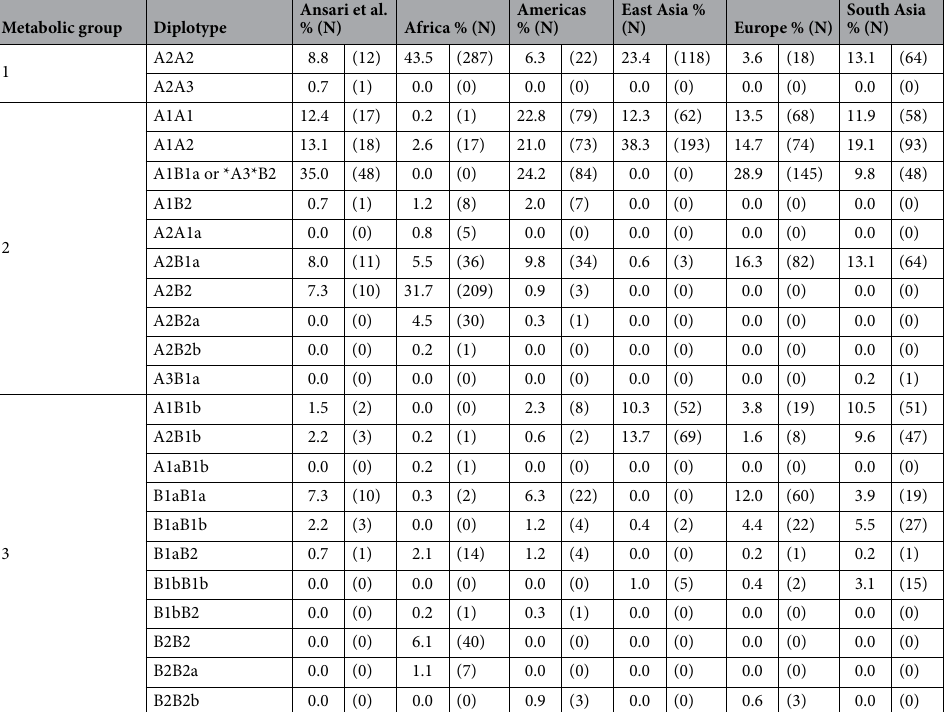
Table 3. GSTA1 diplotype frequency data per super